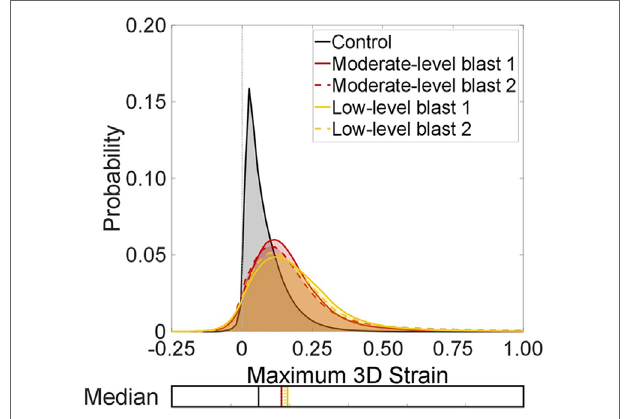
FigUre 7 | Probability distributions for the strain content of each test case to show the global trends between each lung volume in terms of maximum three-dimensional strains. The median for each distribution is also